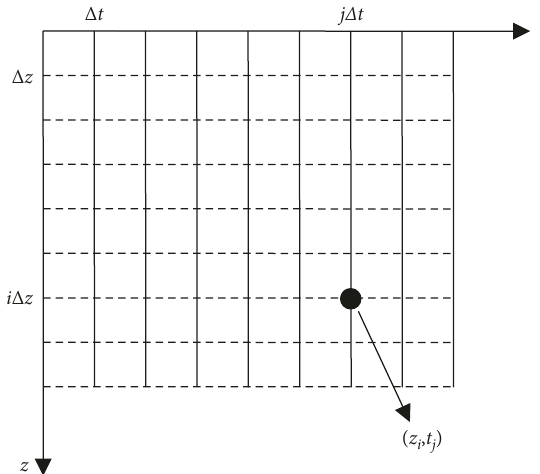
Figure 3: Discrete schematic diagram about the space and